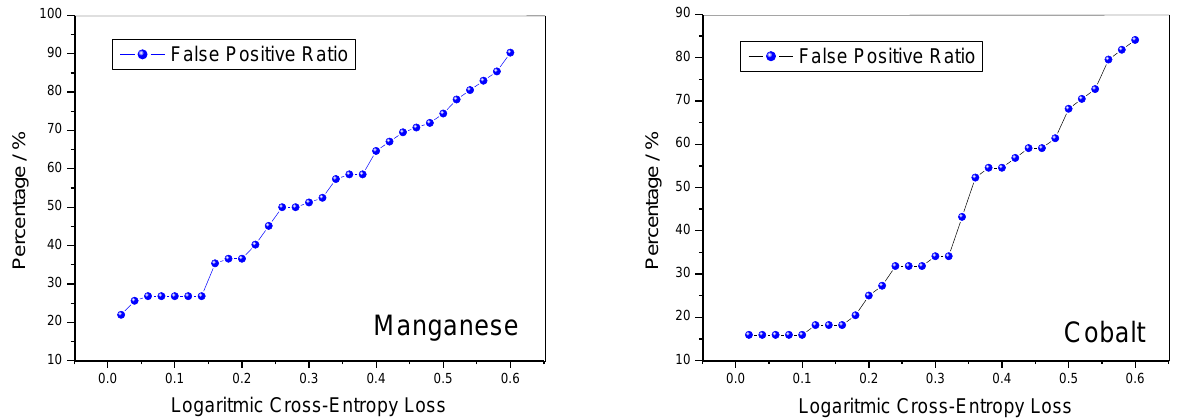
Figure 7. False positive ratio as a function of LCEL value for lithiated manganese ( left ) and cobalt ( right ) oxides.